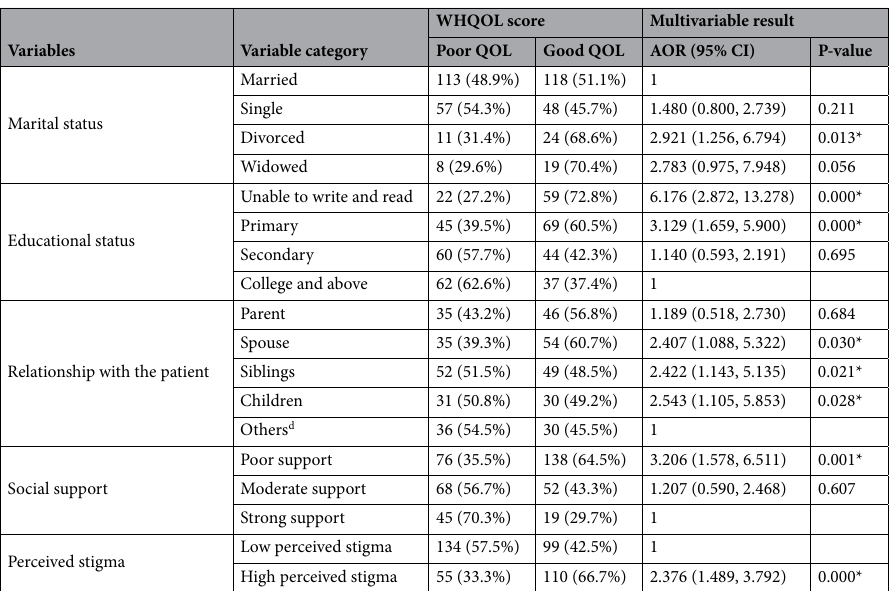
Table 6. Adjusted multivariable analysis model showing independently associated factors with QOL among caregivers of patients with mental illness (n = 398). *p-value < 0.05.